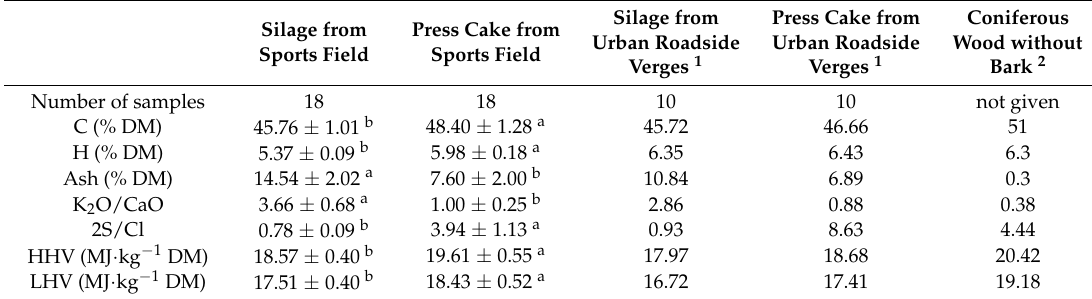
Table 1. Combustion related properties of grass from urban proveniences and coniferous wood. Standard deviations are